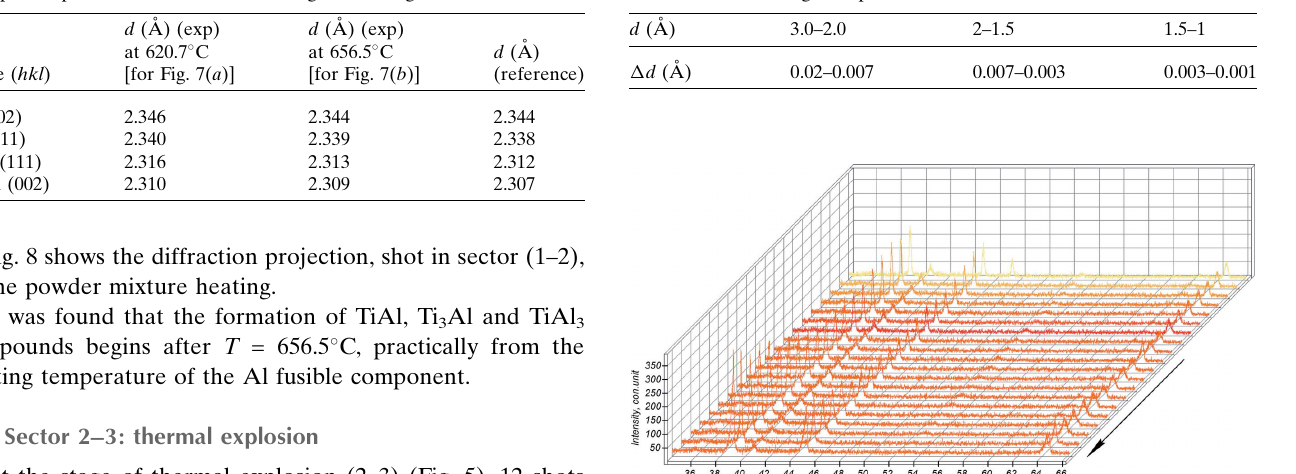
Table 1 Interplanar phase distances for diffractograms in Fig. 7.